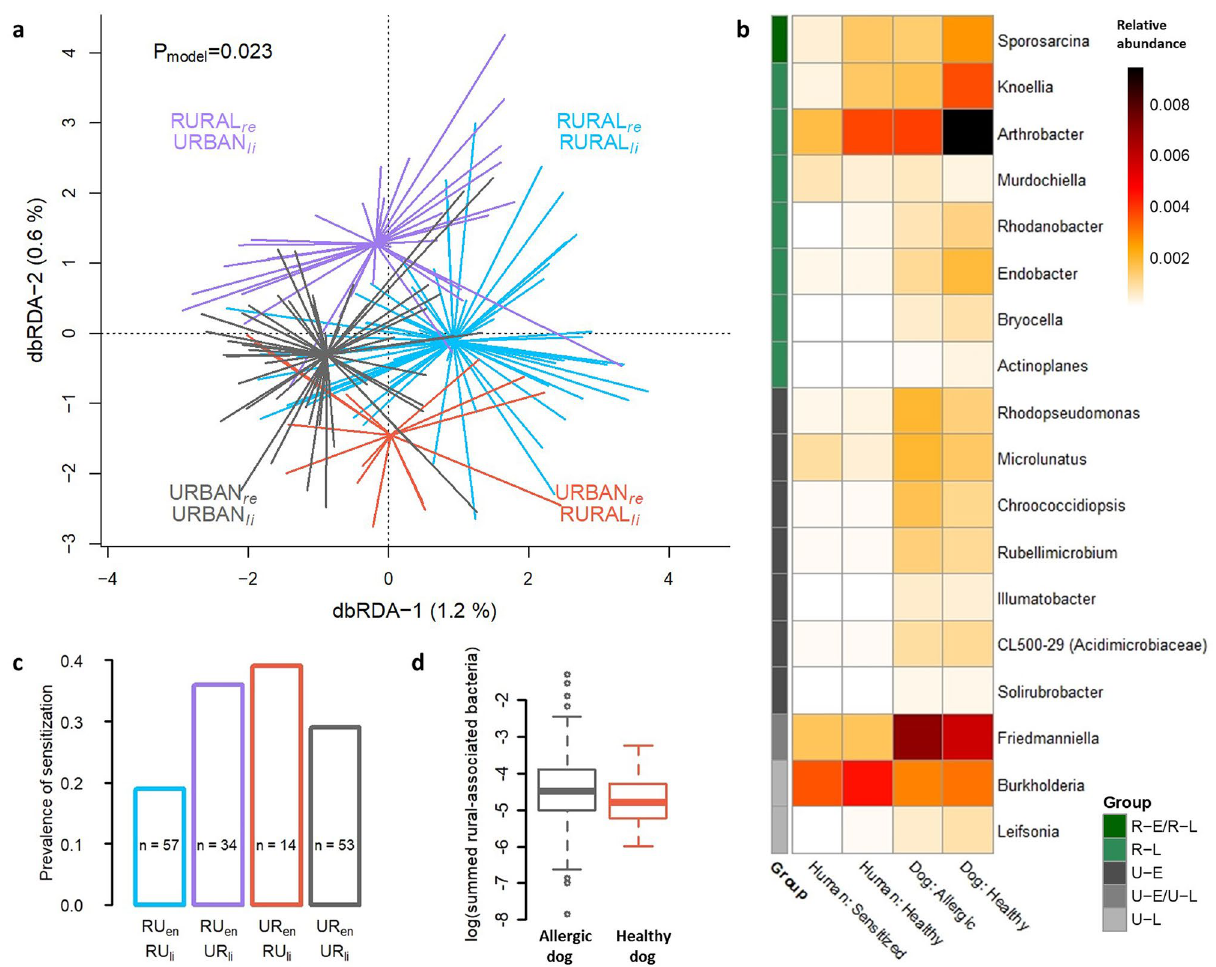
Figure 4. The living environment and lifestyle related skin microbiota in allergic and healthy individuals. Living environment (rural/urban) and lifestyle (rural-type/urban-type) constrained the skin microbiota of dog owners ( a ) in Distance-Based Redundancy Analysis. The prevalence of aeroallergen sensitization in humans showed association with the type of lifestyle and living environment ( c ) as extremes (rural environment + rural lifestyle vs. urban environment + urban lifestyle) were significantly different (ANOVA, p = 0.022). Bacterial genera in skin that significantly differed between rural and urban environments as well as between rural and urban lifestyles, defined with Zero-inflated Log-Normal mixture model, are presented as a heatmap of relative abundancies ( b ). Some of these taxa differ between species as well as between allergic and healthy individuals. RUen = Rural living environment, RUli = Rural lifestyle, URen = Urban living environment, URli = Urban lifestyle, re = residential environment, li = lifestyle, R-E/R-L = Bacteria associated with rural environment and rural lifestyle, R-L = Rural lifestyle associated bacteria, U-E = Urban environment associated bacteria, U-E/ U-L = Urban environment and urban lifestyle associated bacteria, and U-L = Urban lifestyle associated bacteria. The log-transformed, summed relative abundance of rural-associated bacterial genera presented in heatmap were marginally lower in allergic than healthy dogs (p = 0.059; d of borderline significance (ANOVA, p = 0.069). Sprorosarcina, that was associated with rural environment and lifestyle, was more common in healthy than in sensitized humans (p = 0.034; Fig. 4b). We also studied weather the sharing of microbes between dogs and owners relate to allergic traits, based on Bayesian Source Tracking analysis. These analyses produced interesting, but mostly non-significant findings prob- ably due to insufficient sample size. For example, increasing proportion of dog skin related bacteria on human skin showed trend towards decreasing prevalence of aeroallergen sensitization (Logistic regression, p = 0.104, Figs. S6a and S7a). On the other hand, allergic dogs tended to have a higher proportion of the human skin related bacteria than healthy dogs (p = 0.13, Figs. S6b and S7a). Interestingly, even though the median proportion of microbes relating to human skin was very low in the human gut (0.37%), it was significantly higher in allergic (0.43%) than in healthy (0.36%) humans (p = 0.003, Fig. S7b).